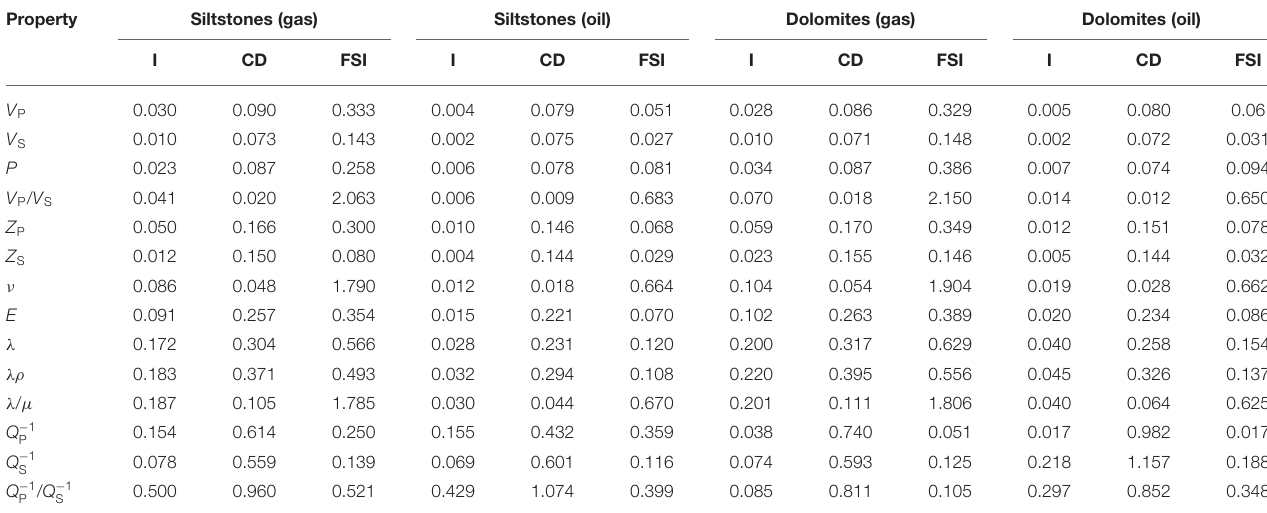
TABLE 3 | Fluid-sensitivity indicators for tight rocks.